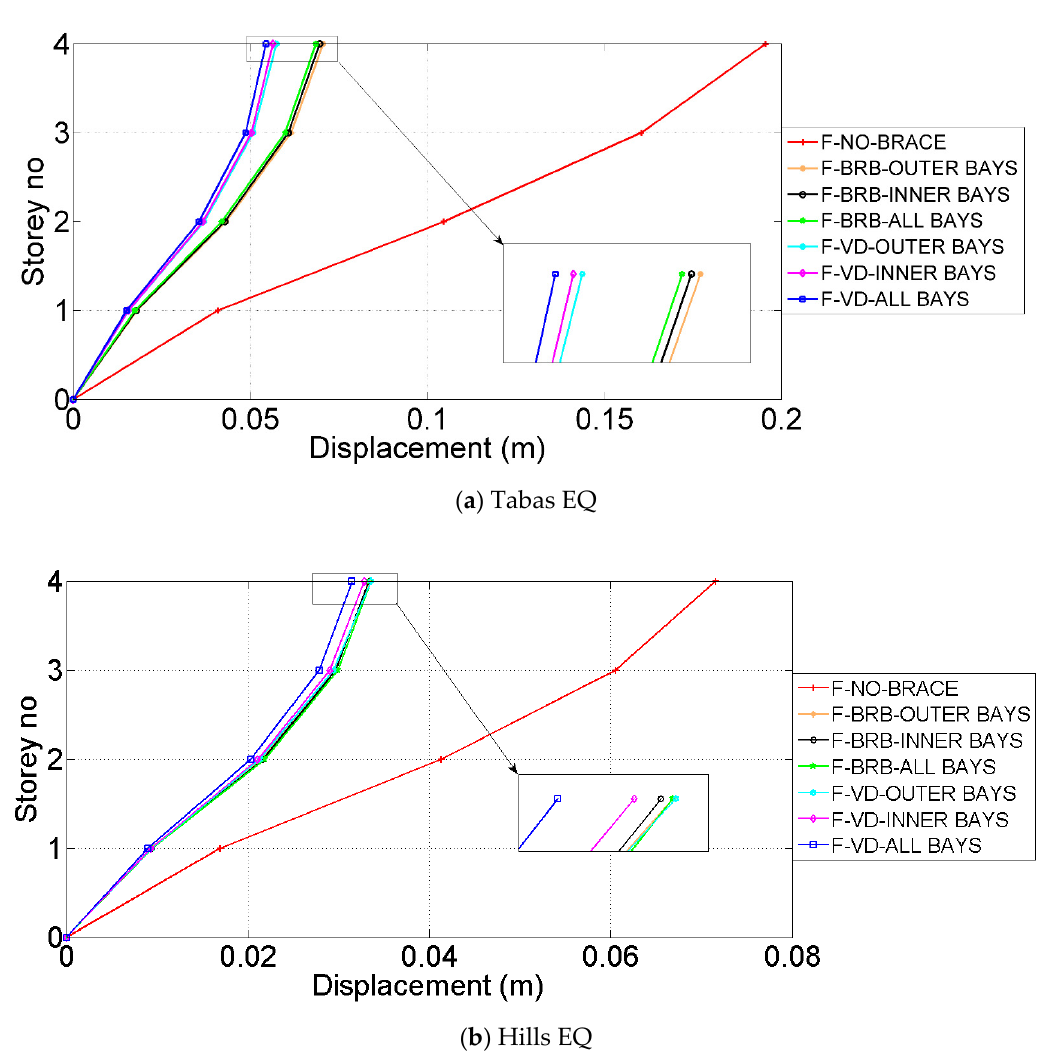
Figure 7. Variation of displacement with story level in 4-story frames.